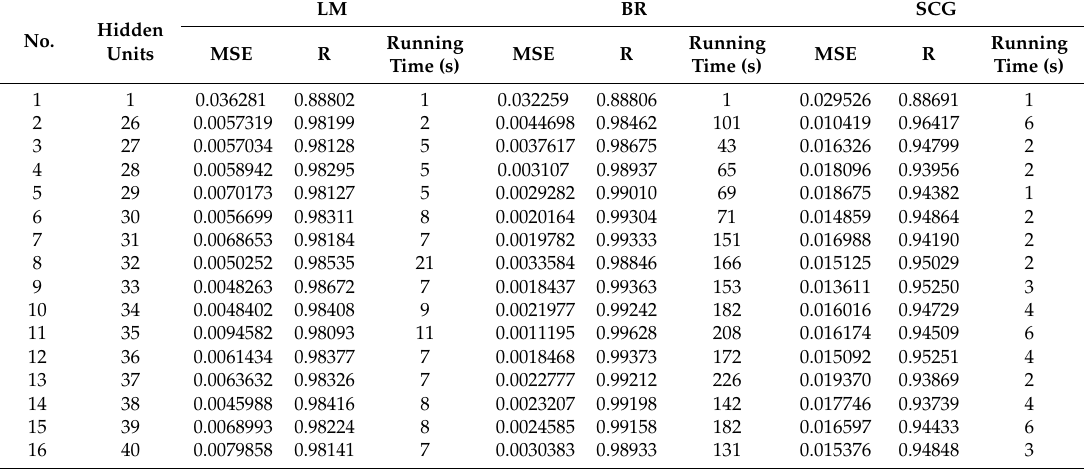
Table 2. A synthesis of the experimental results when developing the feed-forward function fitting neural network (FITNET) ANN forecasting solutions for the produced and consumed electricity.